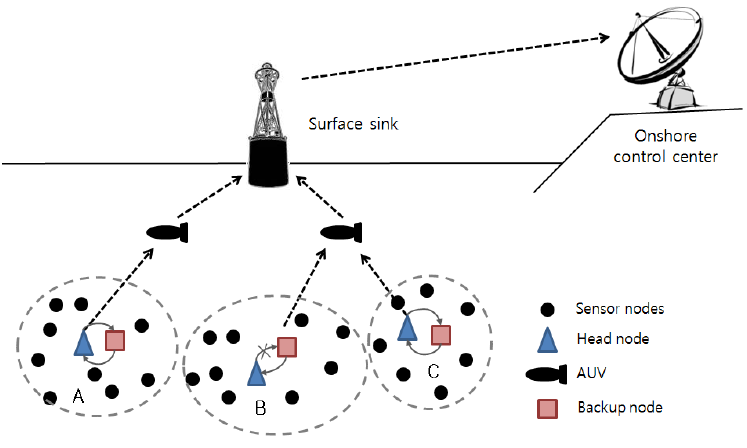
Figure 6. Overview of the proposed